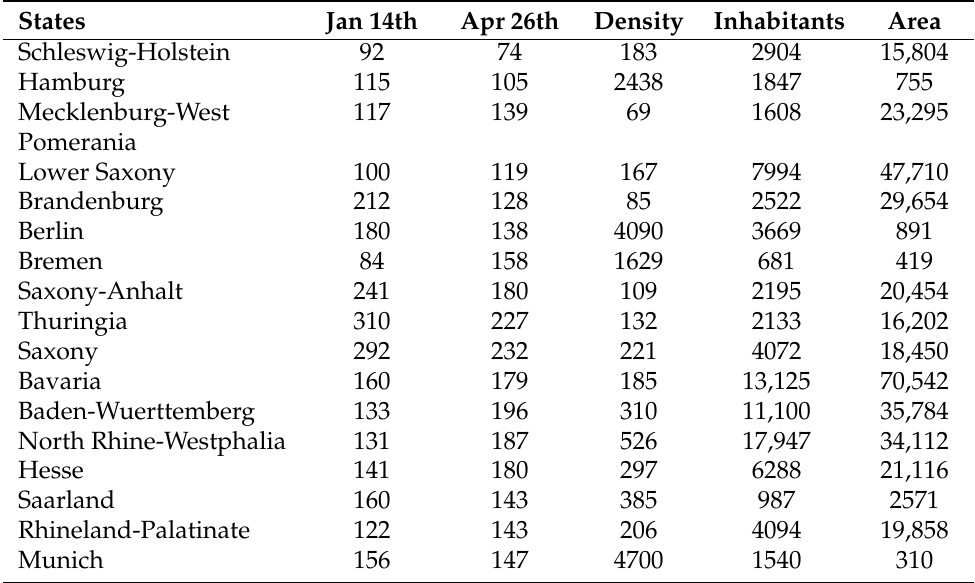
Table 1. Seven-day incidences of 14th January and April 26th, and corresponding people density (per km 2 ), inhabitants (per 100,000), and areas of the federal states of Germany (in km 2 ).